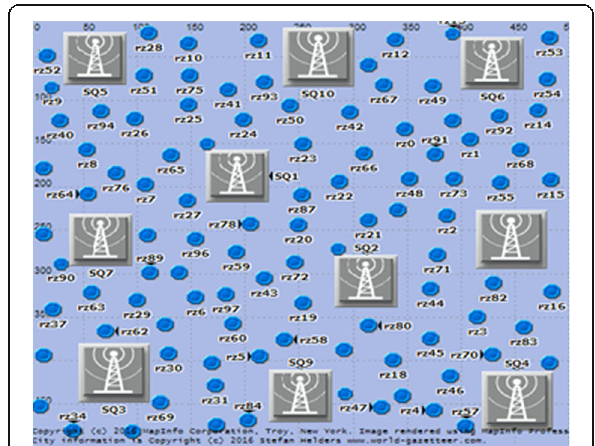
Fig. 4 The network model of the CWSN